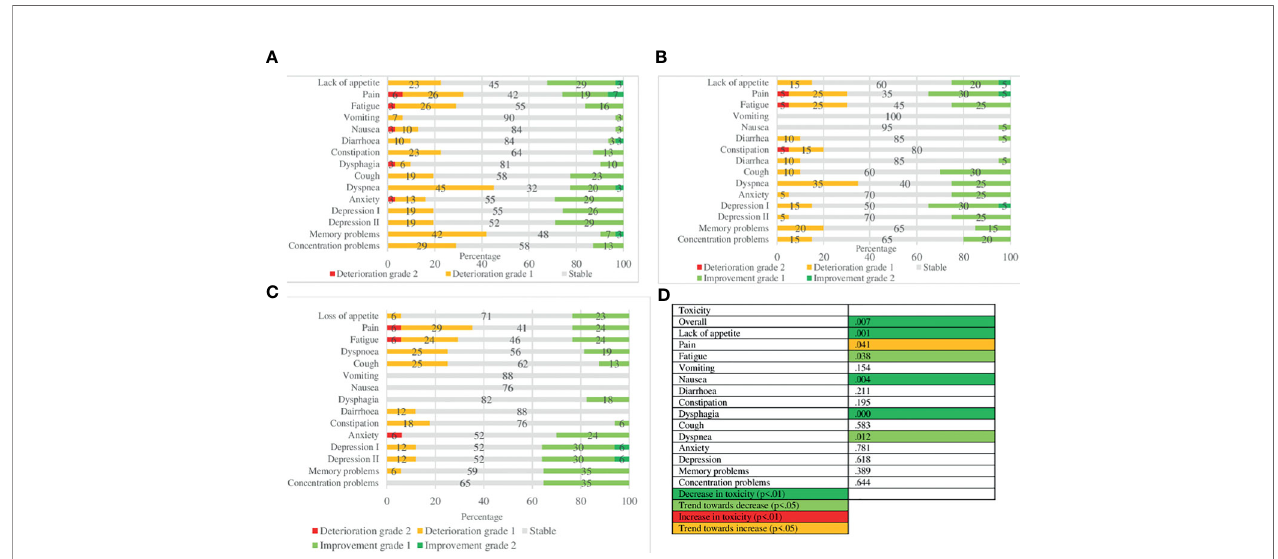
FIGURE 3 | Toxicity over time: MCID and statistical signi fi cance. (A) MCID of toxicity 2/3 months after end of treatment. (B) MCID of toxicity 6 months after end of treatment. (C) MCID of toxicity 12 months after end of treatment. (D) Statistical signi fi cance. TABLE 2 | Percentage of Minimally Clinical Important Difference (MCID) and statistical signi fi cance of neurocognitive tests over time. Test Minimally Clinical Important Difference (MCID) compared to baseline Signi fi cance level 2/3months 6 months 12